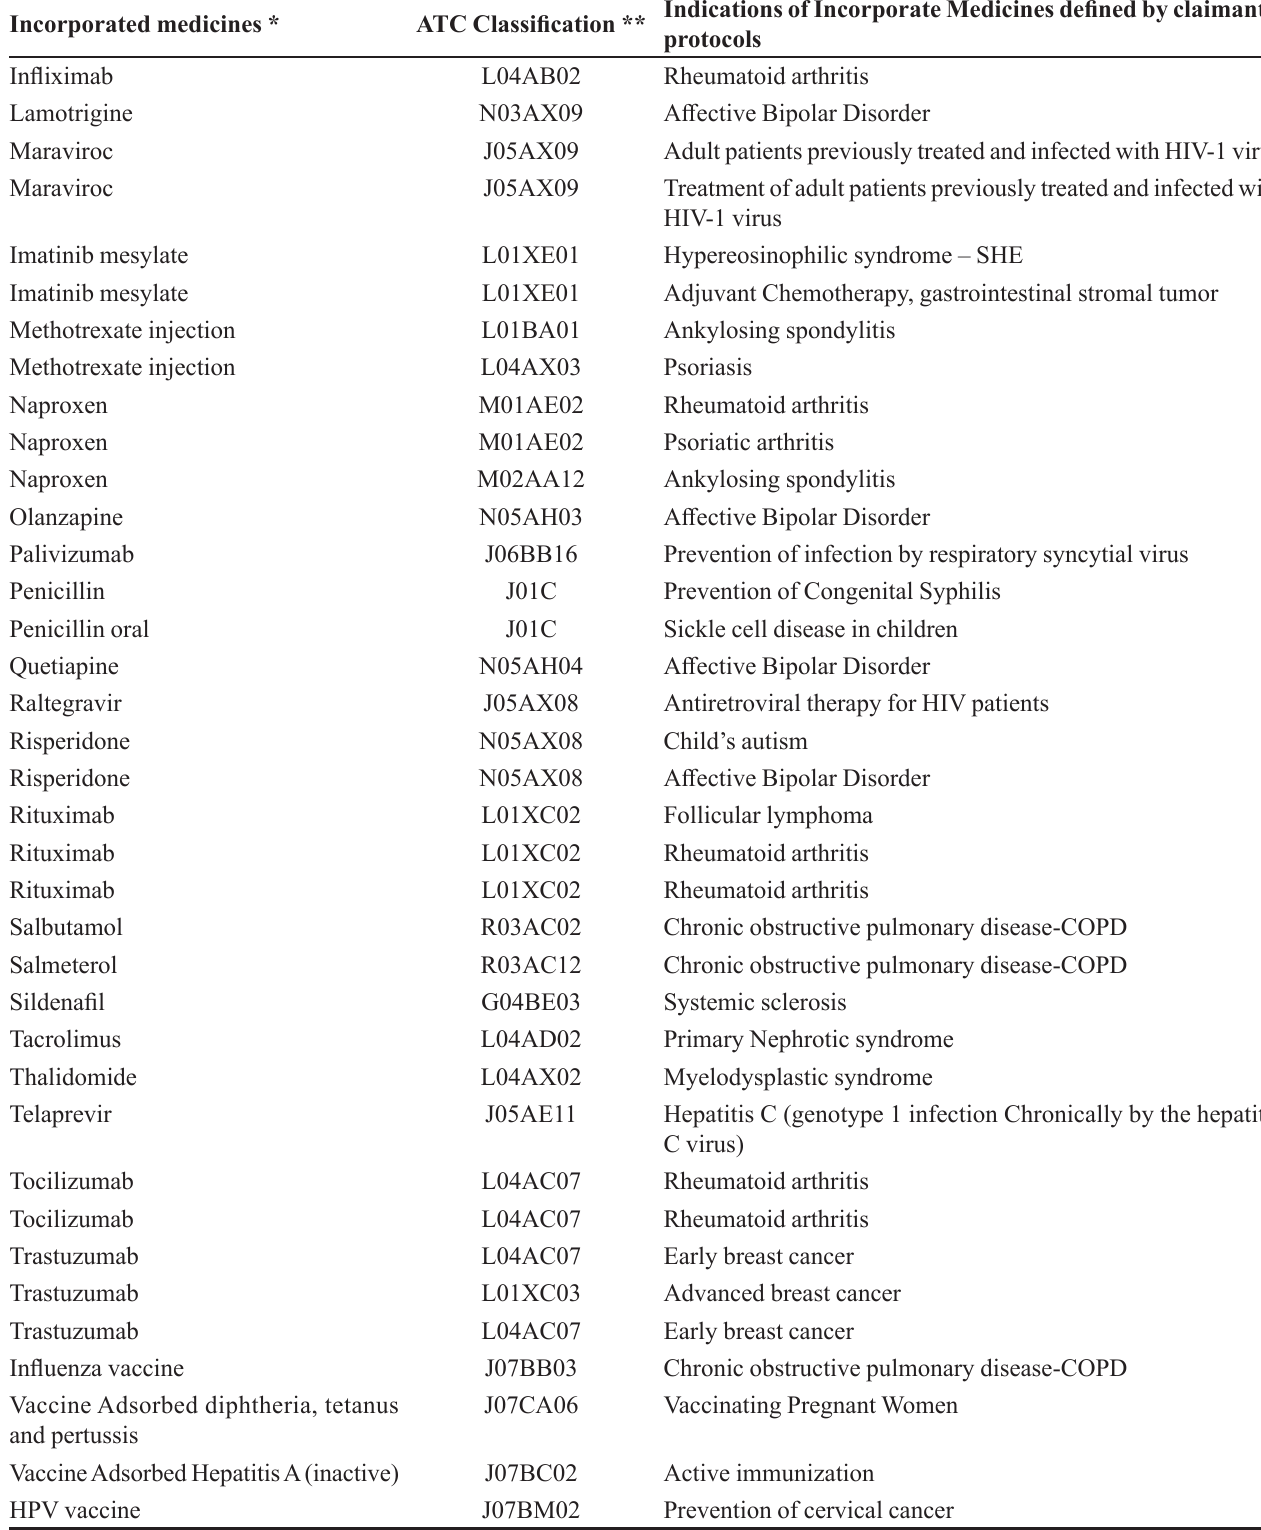
TABLE III - List of medicines incorporated by CONITEC with the respective 5 th level ATC classification and its indications to the National List of Essential Medicines (RENAME). January 2012 - July 2015, Brazil